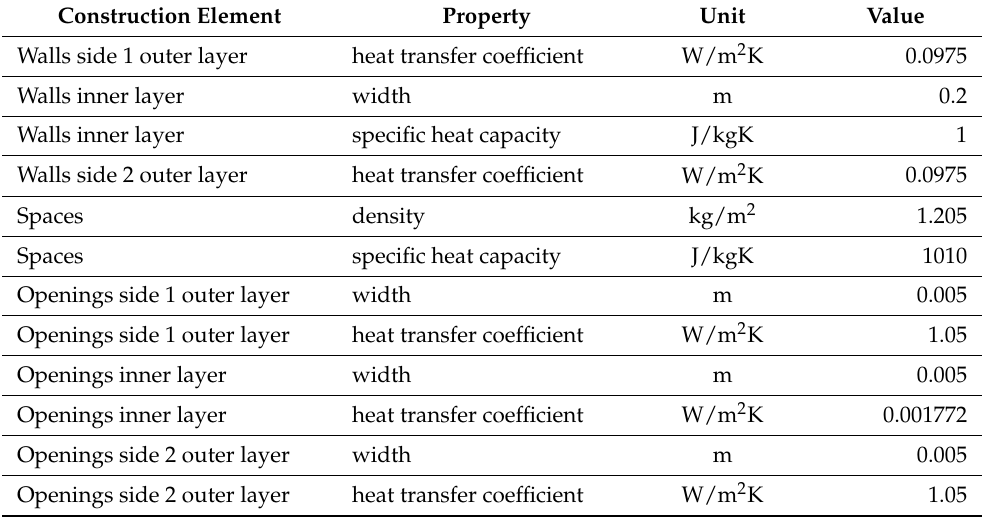
Table A1. Starting values of properties used for calculation parameter of the initial